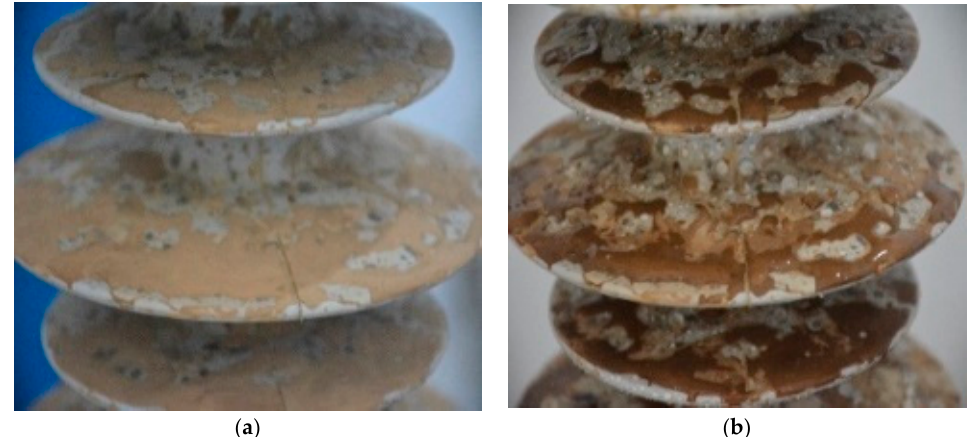
Figure 8. Insulators given fly ash pollutant in ( a ) dry and ( b ) wet conditions.